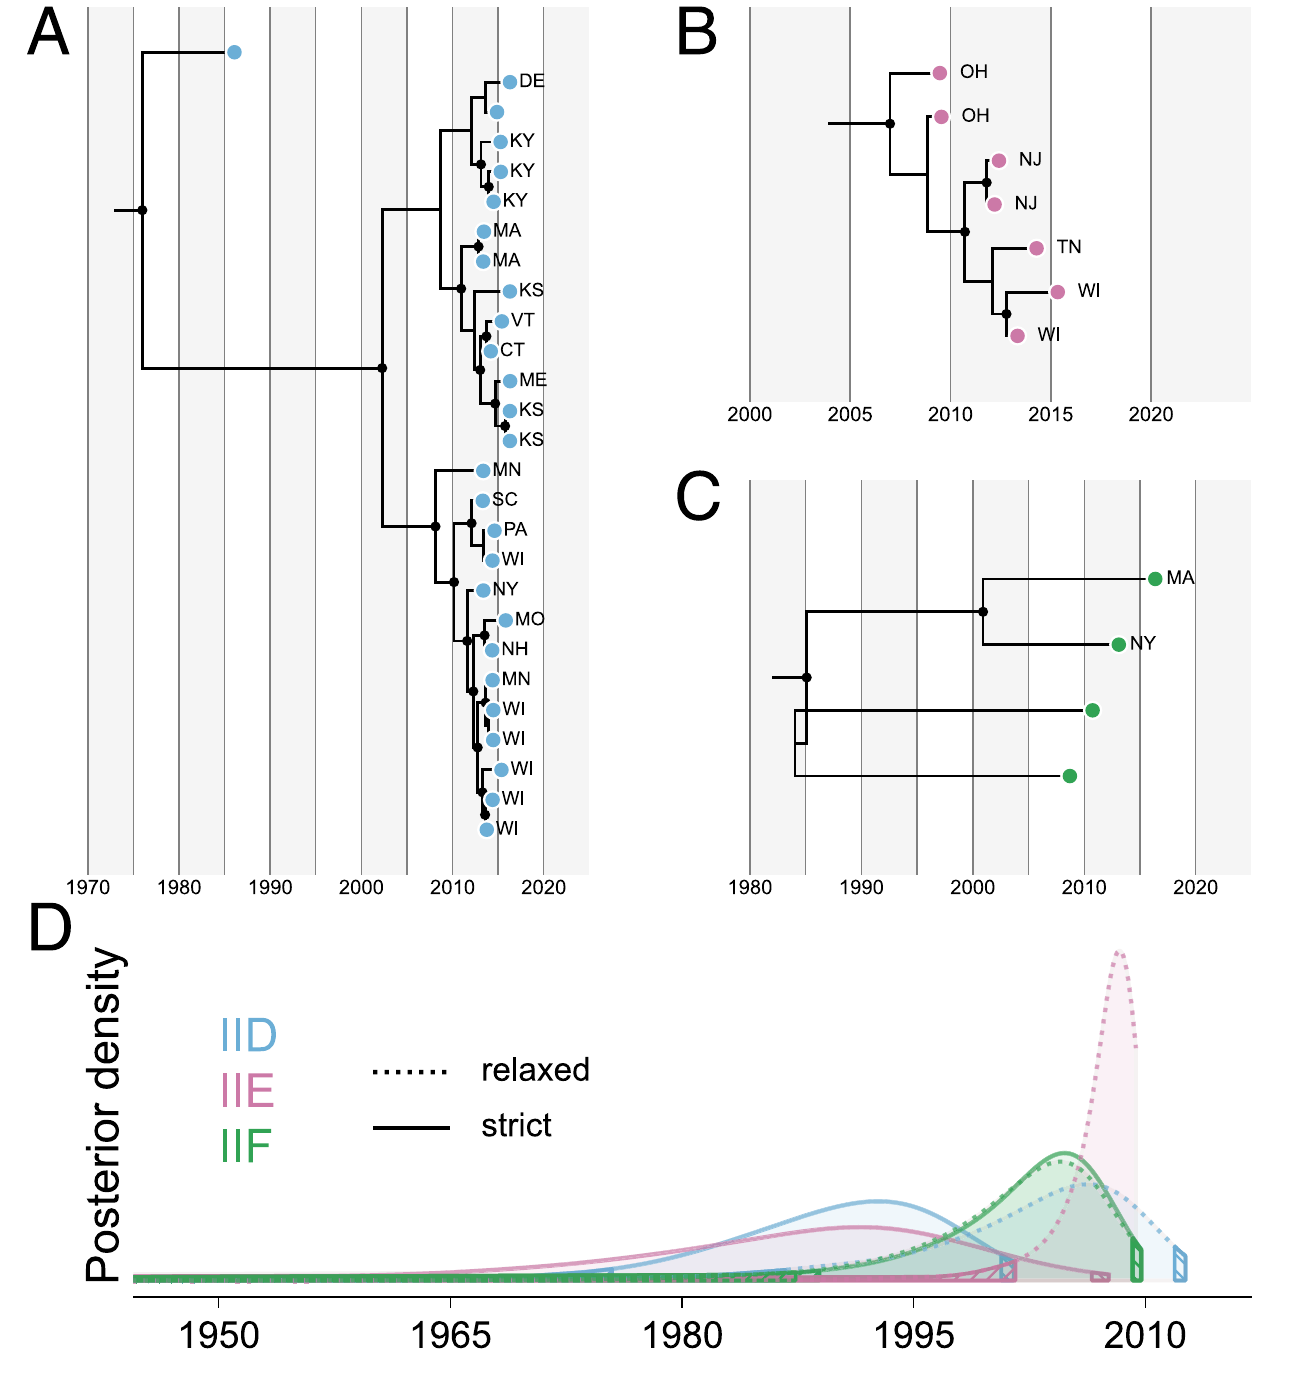
Fig 4. Strains of Ophidiomyces ophiodiicola within the 3 most common clonal lineages on wild snakes in North America likely shared a common ancestor within the last approximately 50–100 years. (A)–(C) show relaxed clock, time-structured Bayesian phylogenies for Clades IID, IIE, and IIF, respectively. Each phylogeny was built using an alignment of 19,562,499–19,658,811 base pairs within the nuclear genome and nodes represent mean age estimates for each node. Filled black circles indicate nodes with posterior support � 95. For each strain collected from a wild snake, the state within the USA is indicated using 2-letter abbreviations (strains from captive snakes are not labeled). (D) Posterior probability distributions for the tMRCAs of clonal lineages IID (blue), IIE (pink), and IIF (green). Estimates from analyses using strict and relaxed clock models are shown with solid and dotted lines, respectively. Only strains isolated from wild snakes were considered in the calculation of tMRCAs. Hatched regions represent the tails of each distribution that fall outside of the 95% HPD. Data underlying this figure can be found in OSF: https://osf.io/fmbh5/. HPD, highest posterior density; tMRCA, time of the most recent common ancestor.